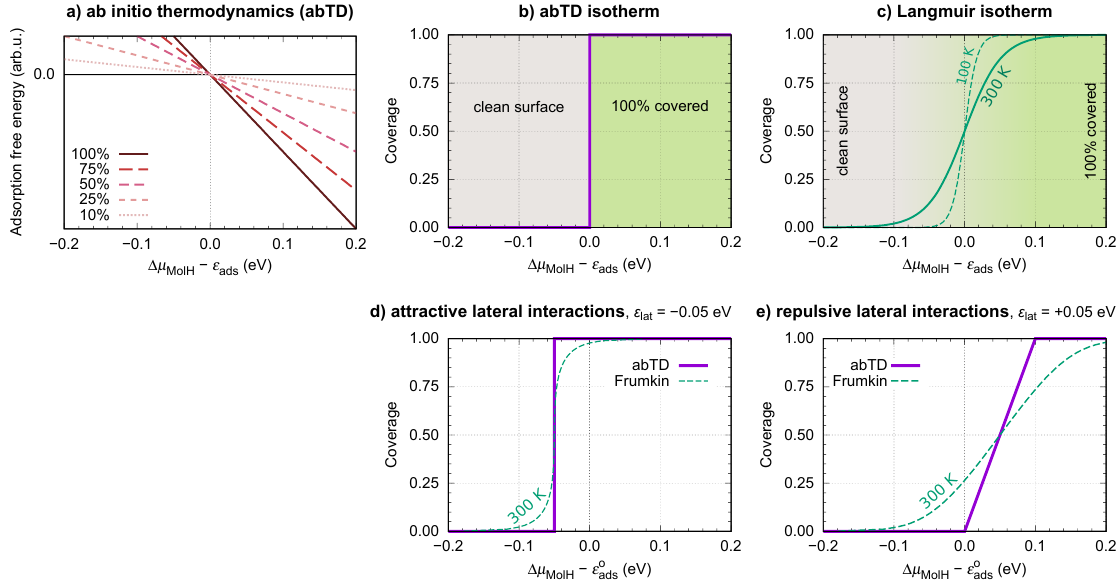
Figure 9. Comparison of approximate ab initio thermodynamics (abTD) approach, Equation (11), compared to Langmuir and Frumkin adsorption isotherms. ( a ) Adsorption free energy per unit area as a function of molecular chemical potential, calculated by Equation (11), for the case when the adsorption energy is independent from the coverage (i.e., Langmuir adsorption model) and the corresponding ( b ) “abTD” isotherm. ( c ) Langmuir adsorption isotherms at T = 100 and 300 K. Comparison between “abTD” and Frumkin isotherms at T = 300 K for ( d ) attractive lateral interactions, ε lat = − 0.05 eV and ( e ) repulsive lateral interactions, ε lat = + 0.05